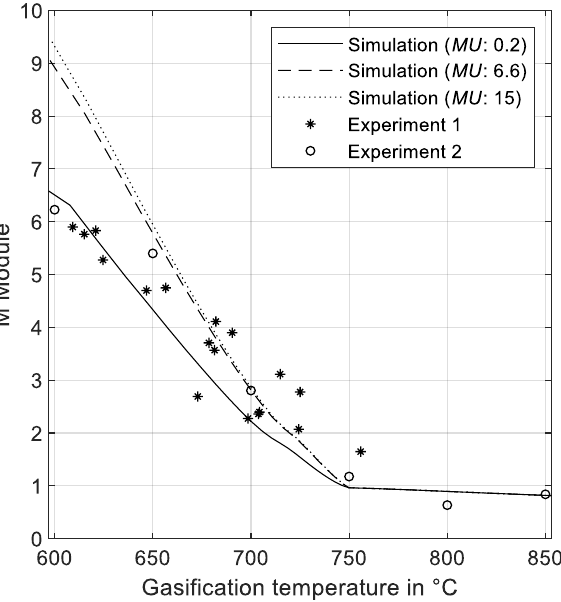
Figure 10. Influence of gasification temperature and make-up mass flow (lines for 0.2, 6.6, and 15 kg/h) on M module.